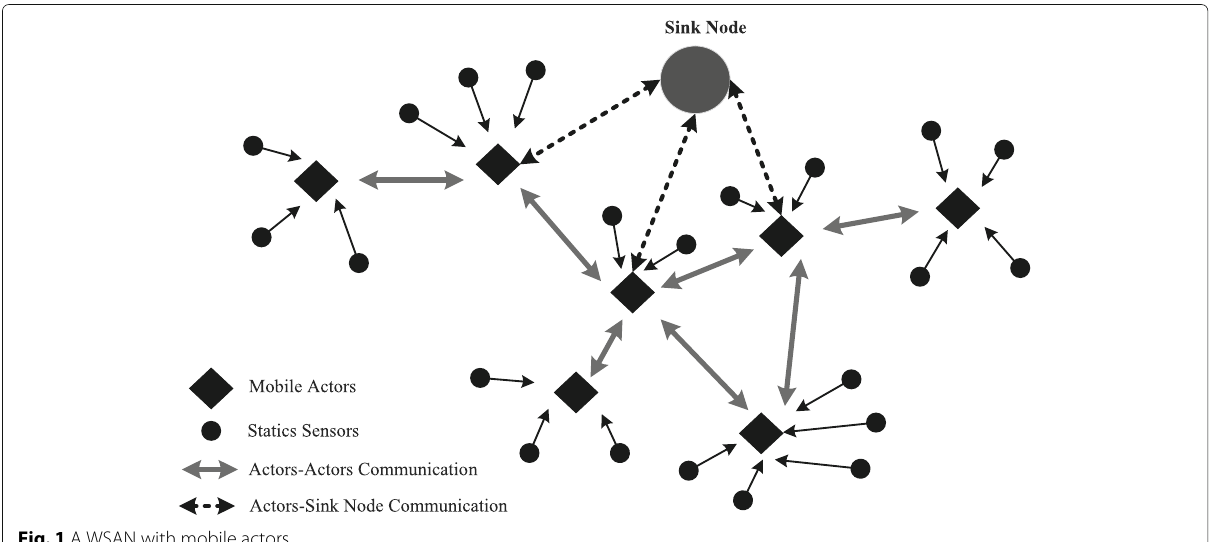
Fig. 1 A WSAN with mobile actors